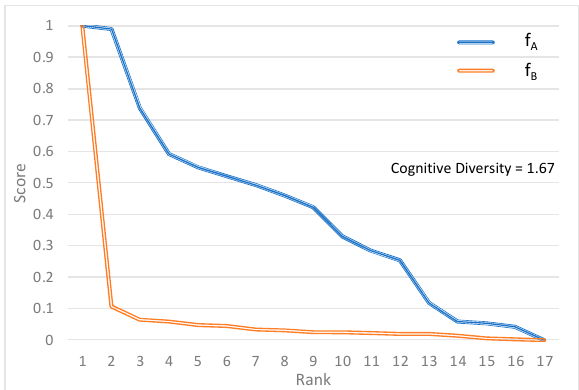
Figure 3. Rank-score functions f A and f B for high cognitive diversity case [30].